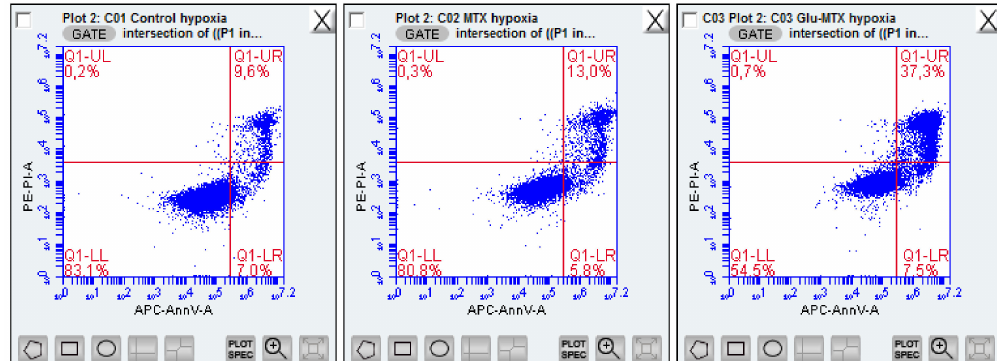
Figure 5. Results demonstrate representative images of flow cytometry analysis of viable (LL-lower left), early (LR-lower right), late (UR-upper right) apoptotic, and dead (UL-upper left) MCF-7 cells after incubation with 10 µ M of MTX and Glu-MTX for 48 h in the tumor microenvironment in comparison to the control group without any treatment. All the samples were prepared using an Annexin V-FITC and PI Apoptosis Detection Kit (Abcam) and analyzed using a FACS Calibur flow cytometer (Beckton Dickinson, NJ, USA)